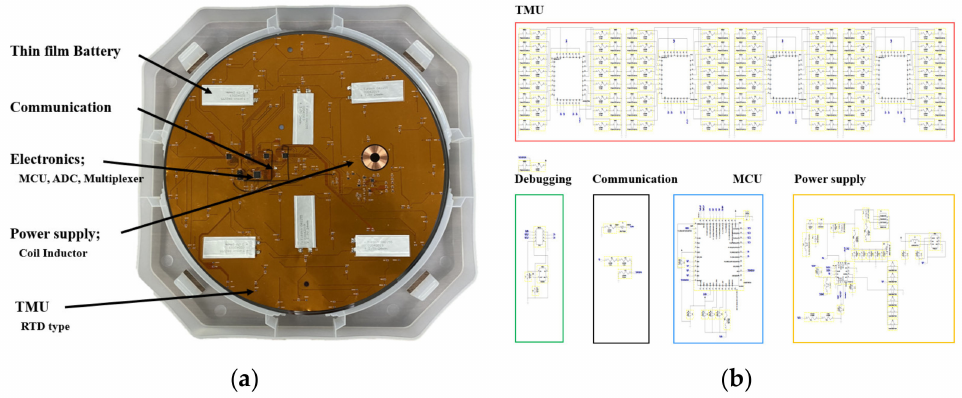
Figure 5. Prototype of OTMS. ( a ) Hardware design of OTMS, ( b ) circuit schematic of